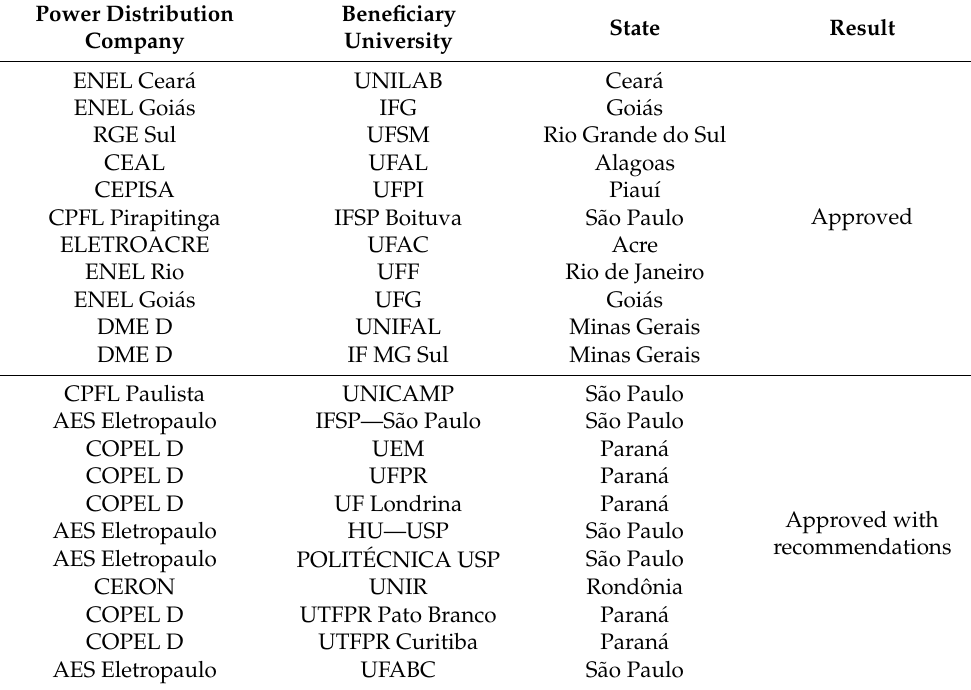
Table 1. Result of the Public Call for Priority Projects for EE and Strategic R&D no. 01/2016—“energy efficiency and mini generation in public institutions of higher